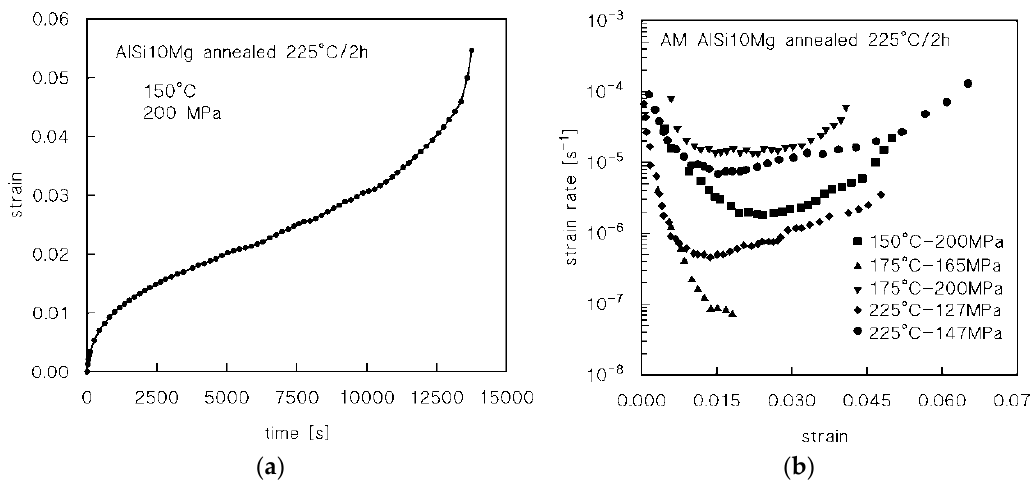
Figure 3. Experimental creep curves: ( a ) example of strain vs. time curve; ( b ) strain rate vs. strain curves at different experimental conditions.